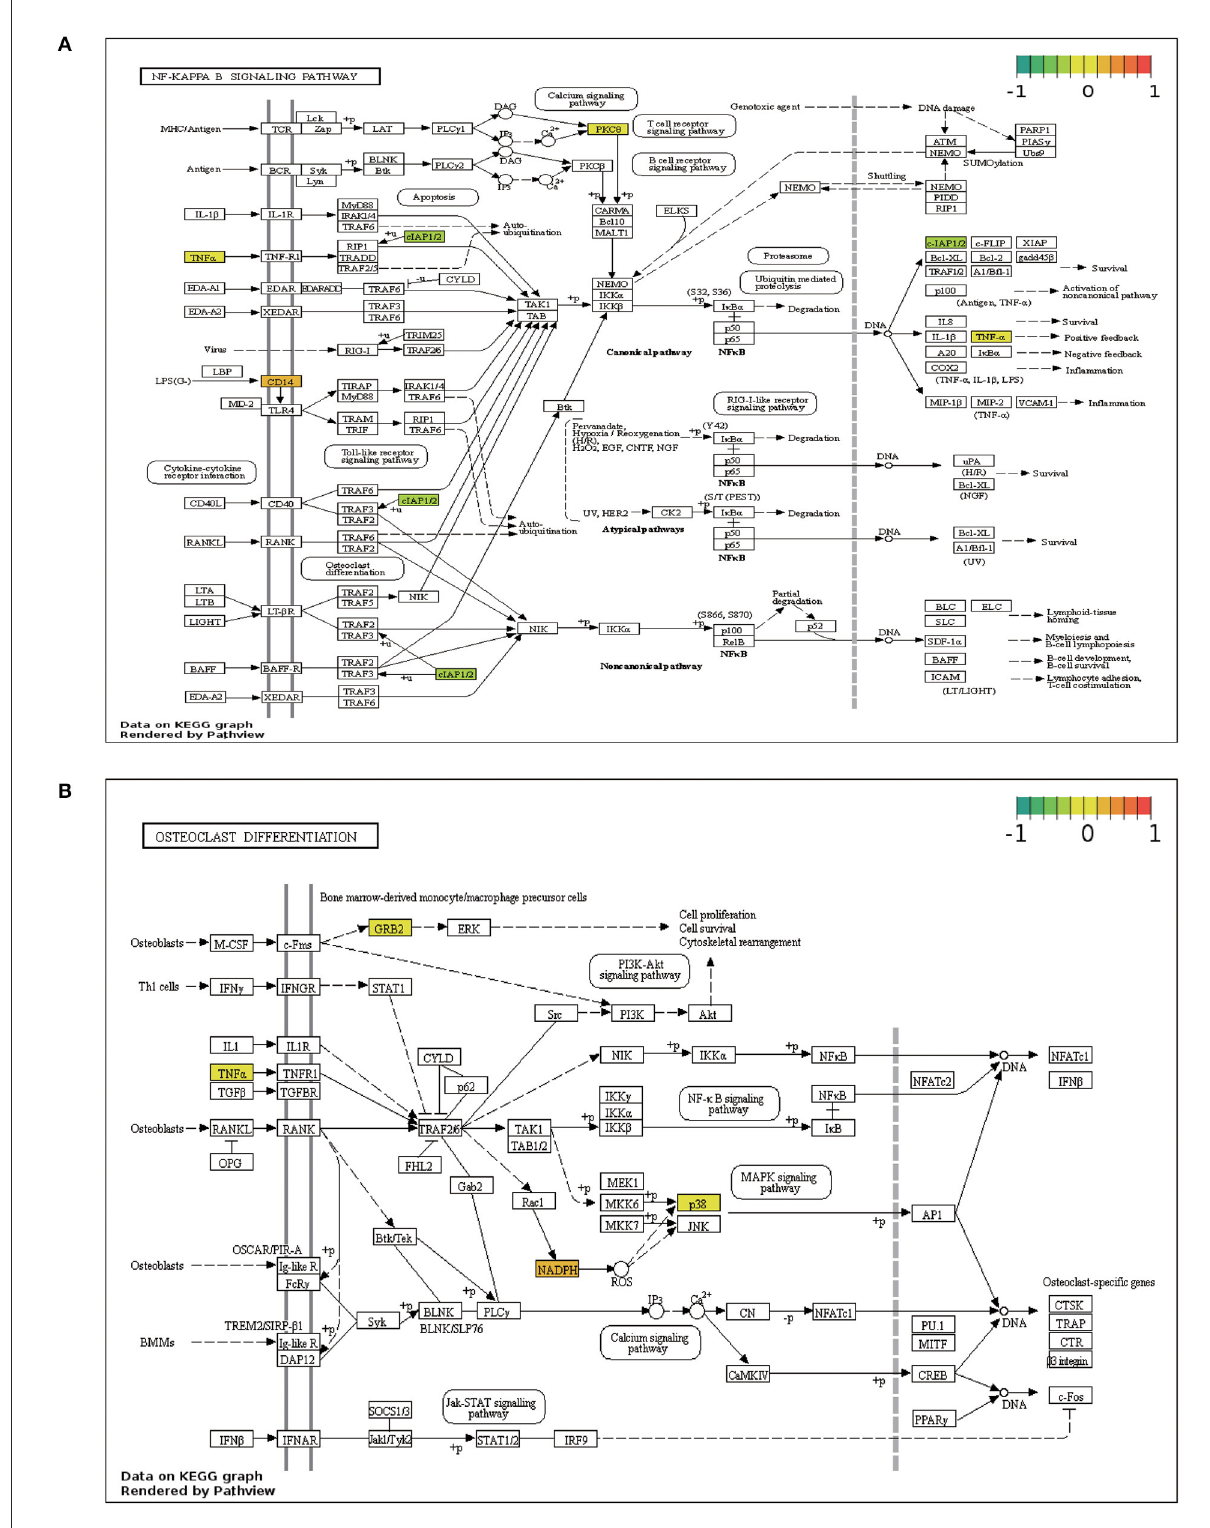
FIGURE6 Pathview map. (A) NF- κ B signaling pathway. (B) Osteoclast differentiation signaling